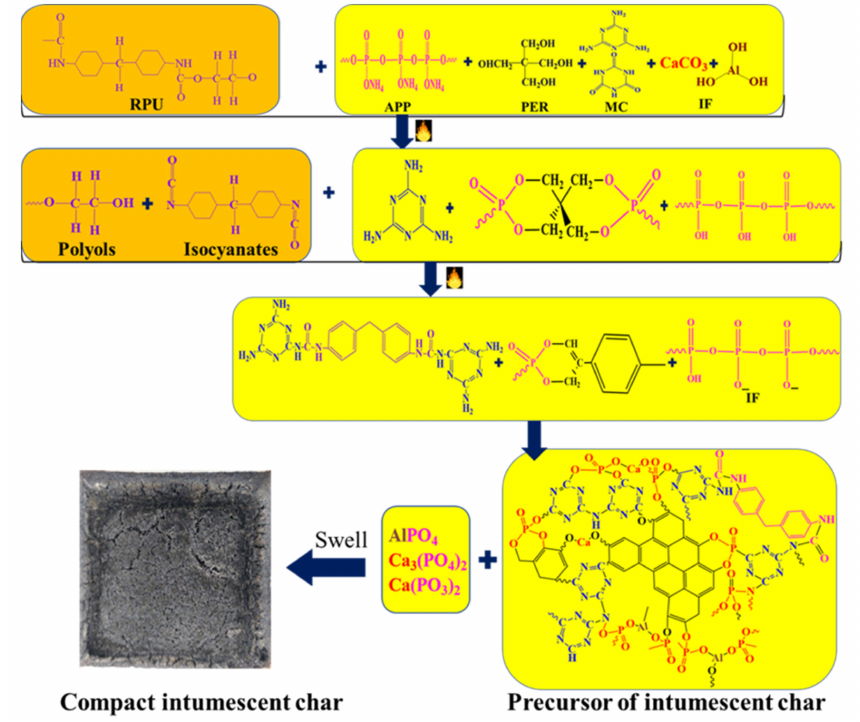
Figure 7. Possible flame retardant mechanism during the combustion process. Here, the inorganic filler (IF) contains CaCO 3 and